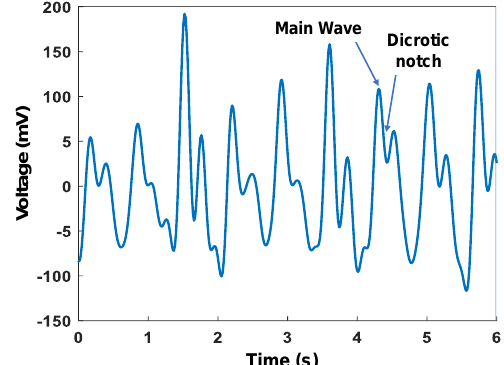
Fig. 8. Measured pulse wave signal at the wrist